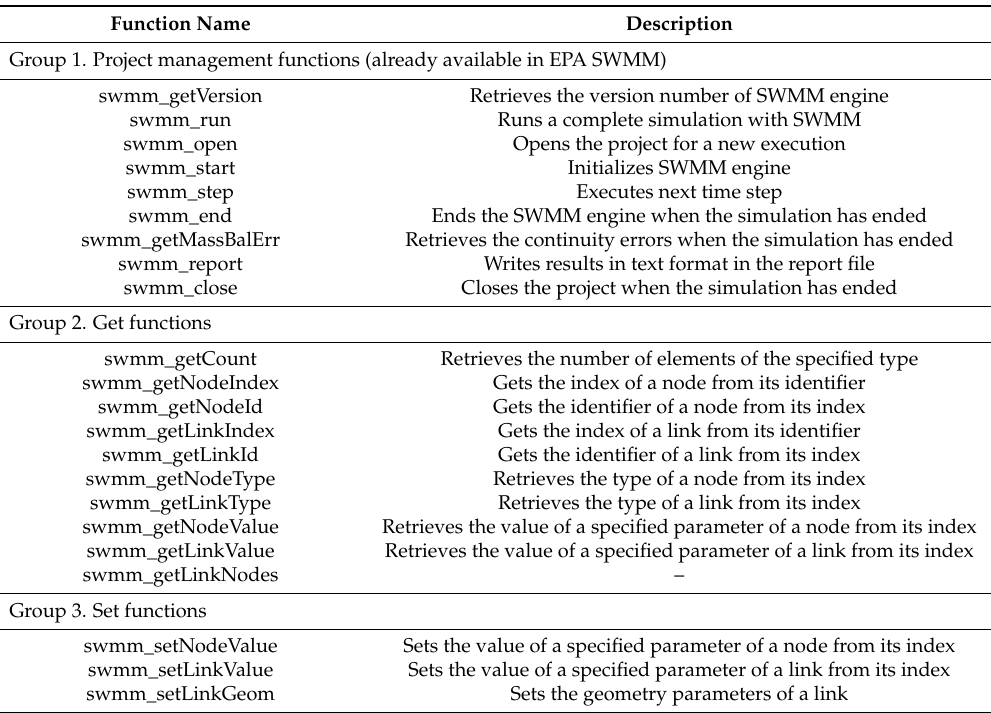
Table 1. Functions included in the Toolkit.